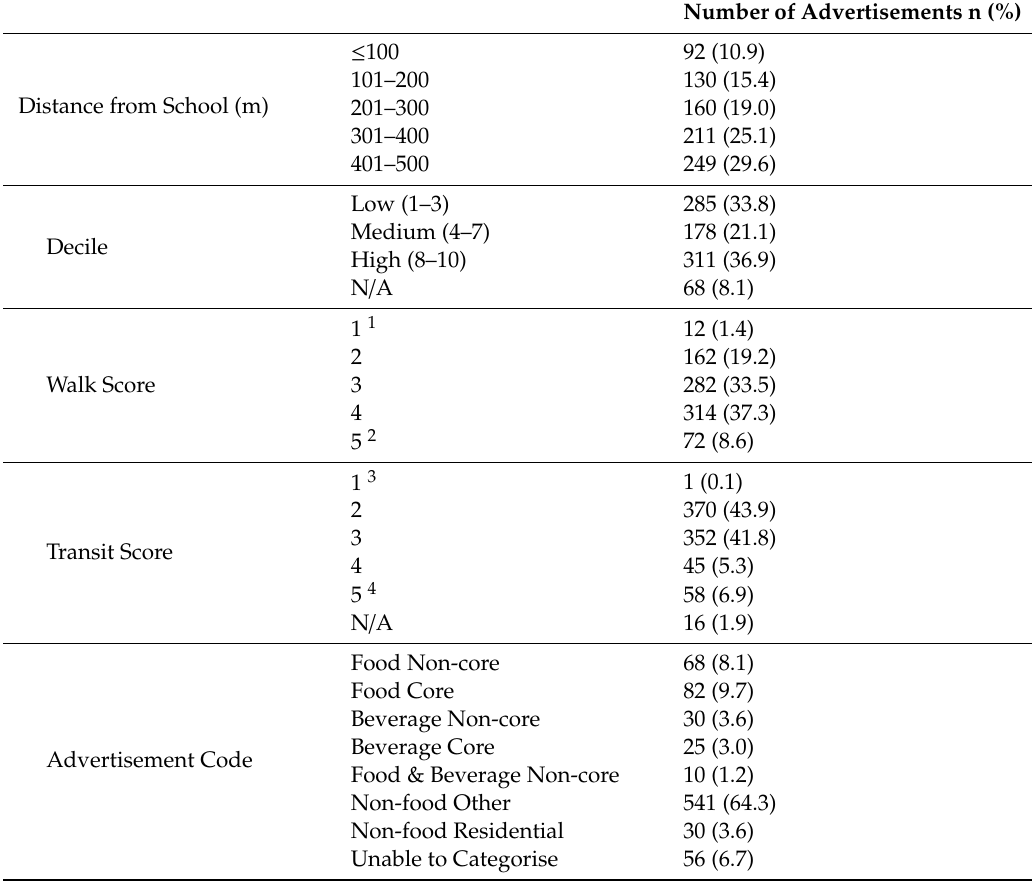
Table 2. Basic Descriptive Table of